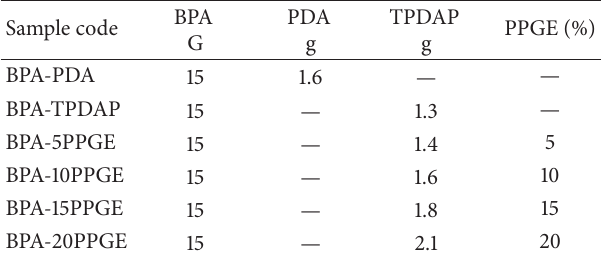
Table 1: Sample codes and resin